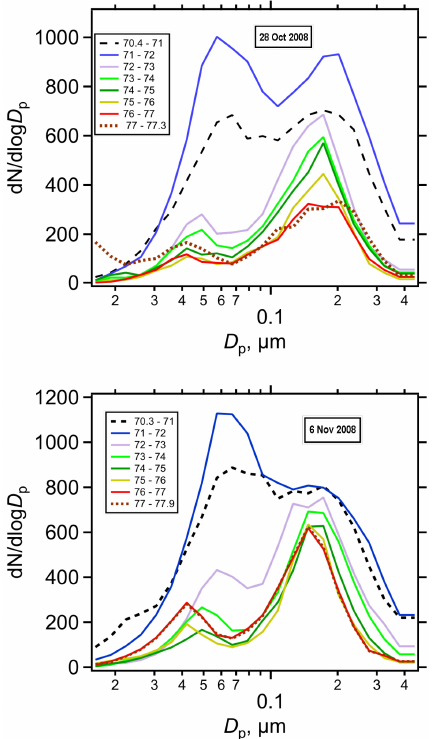
Figure 14. MBL aerosol particle size distributions during return legs on 28 October 2008 and 6 November 2008 as a function of longitude with data binned into 1 ◦